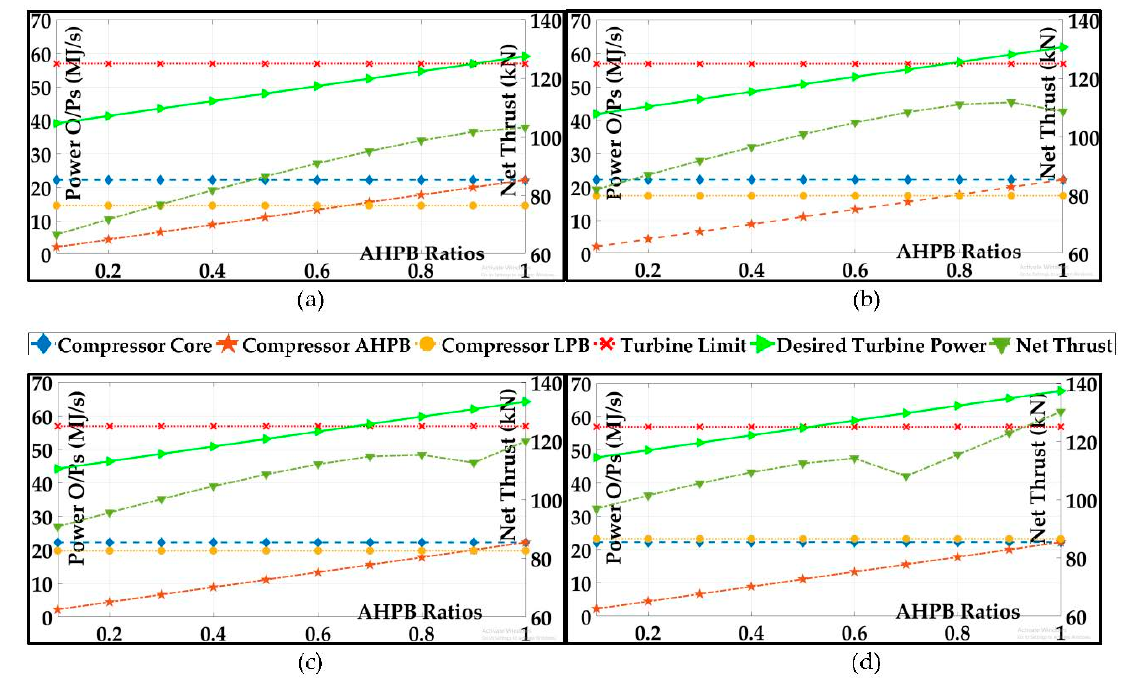
Figure 7. Plots of power output and net thrust vs. AHPB ratios for ( a ) LPB = 2; ( b ) LPB = 6; ( c ) LPB = 10; ( d ) LPB = 12.